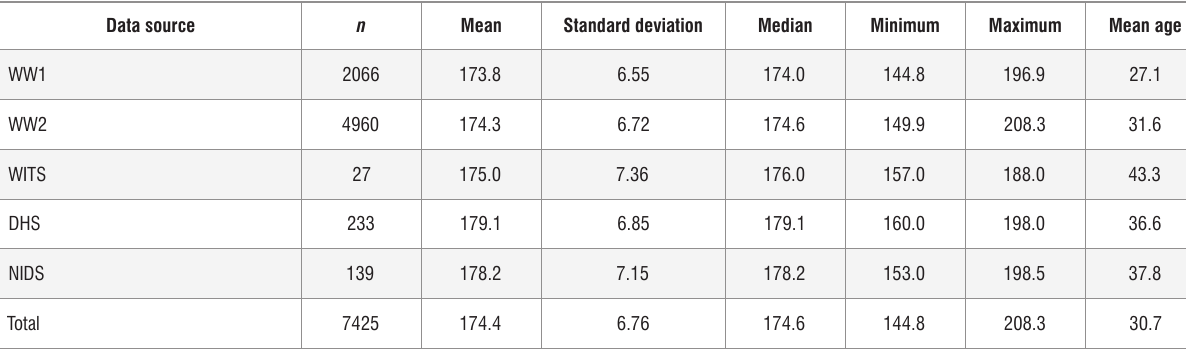
Table 3: Summary of the statistics relating to heights of white men from four data sources Data